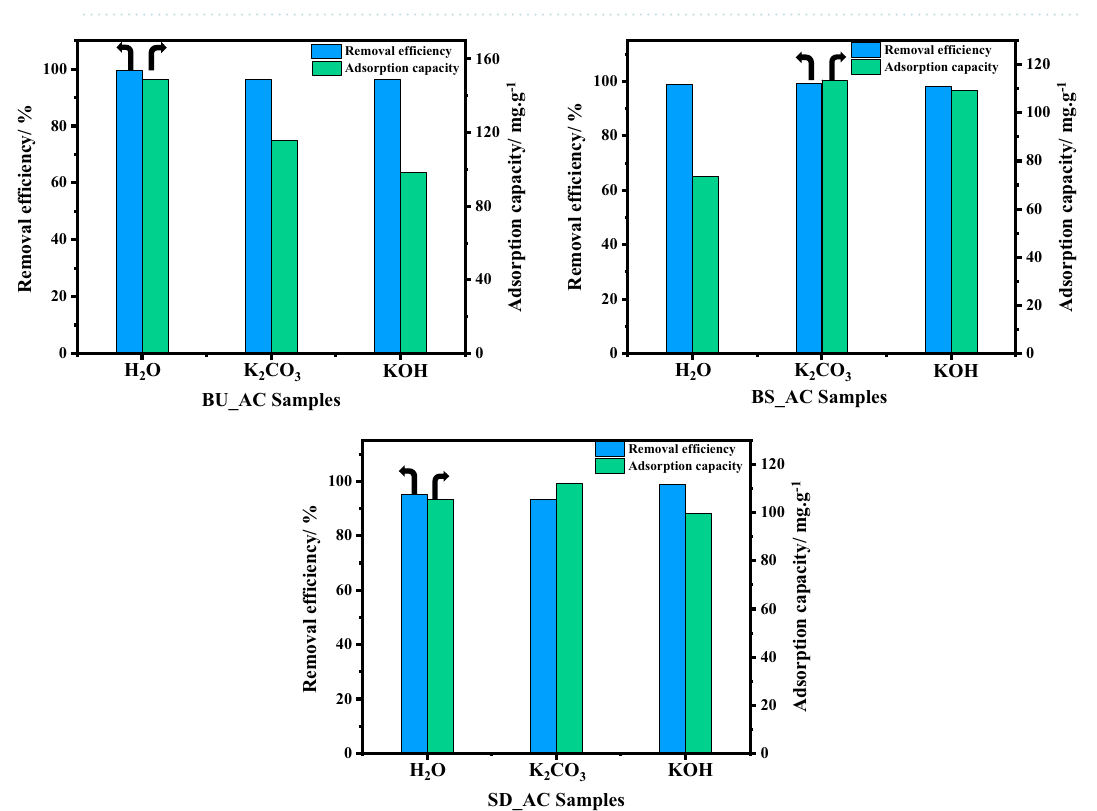
Figure 9. Maximum adsorption capacity and adsorption efficiency of MB solution under the same conditions of temperature, pH, and MB dose (25 °C, 6.5–7, 100 mg L −1 ) for AC